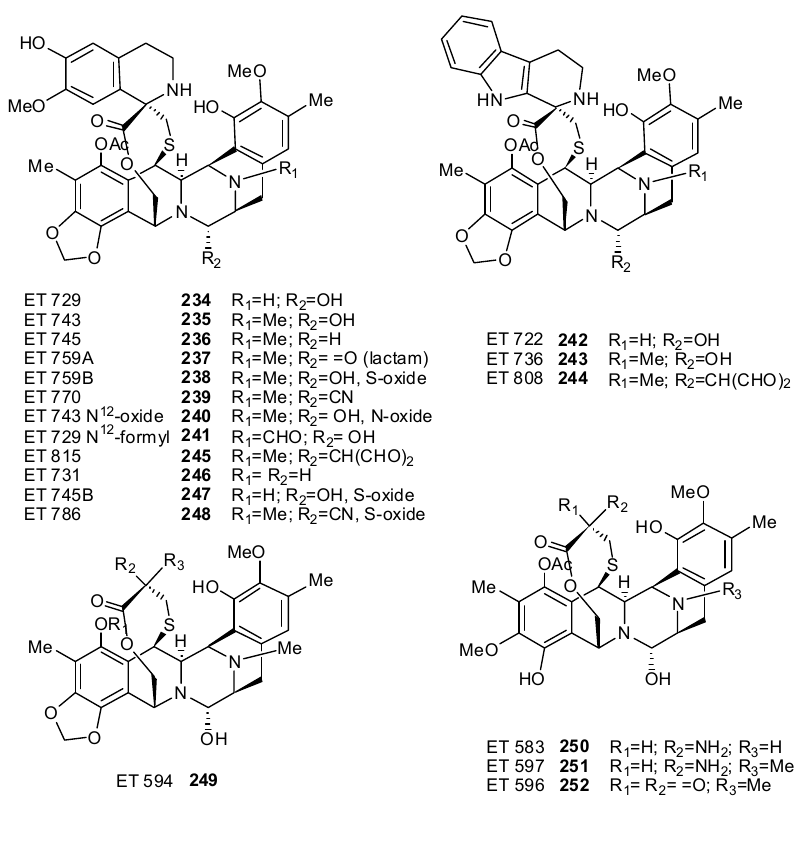
Figure 26. Structures of